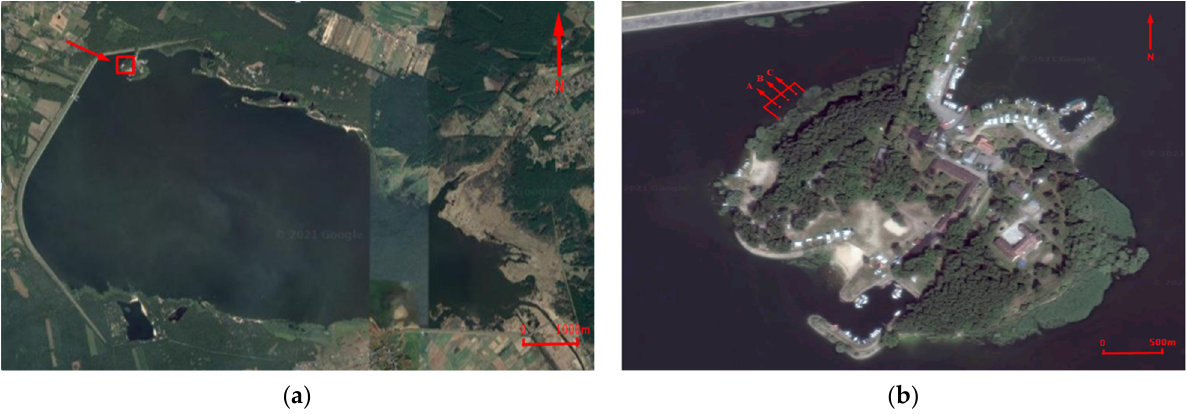
Figure 2. ( a ) Turawa reservoir map and ( b ) the experimental area map (https://www.google.com/maps; accessed date: 10 November 2021).